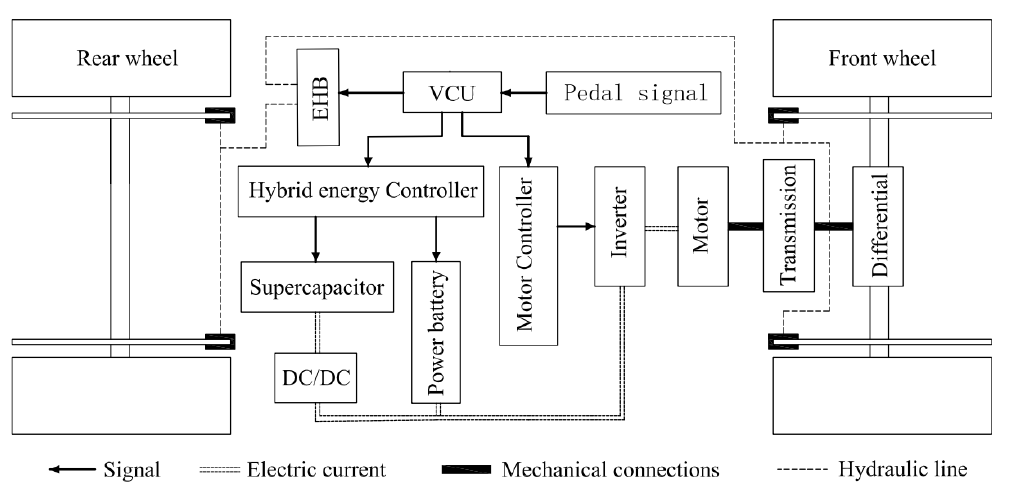
Figure 6. Working principle diagram of HERBS.